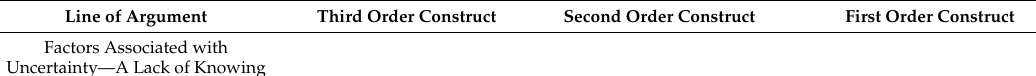
Table 4. Lines of